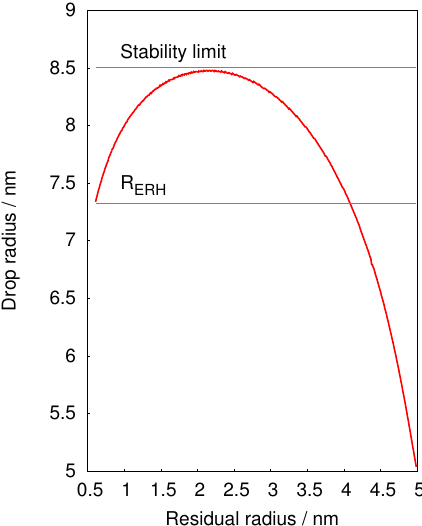
Figure 5. Chemical potential of solvent molecules in the liquid film given in thermal units, b (β → α) , as a function of the film thickness, h , according to Eq. (5) at R N = 5nm.